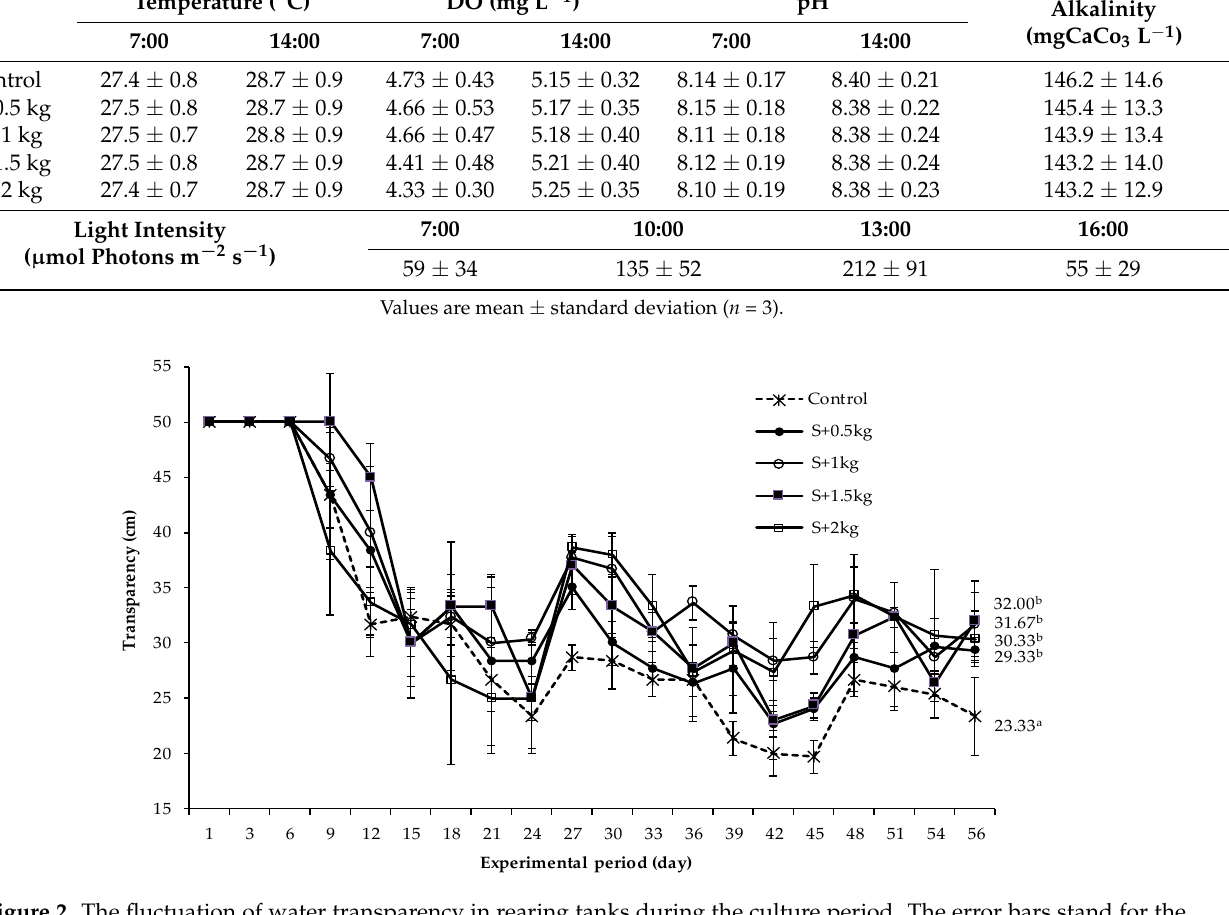
Figure 2. The fluctuation of water transparency in rearing tanks during the culture period. The error bars stand for the mean values and standard deviation. The different superscripts a, b illustrates the statistical difference in water transparency among the treatments.